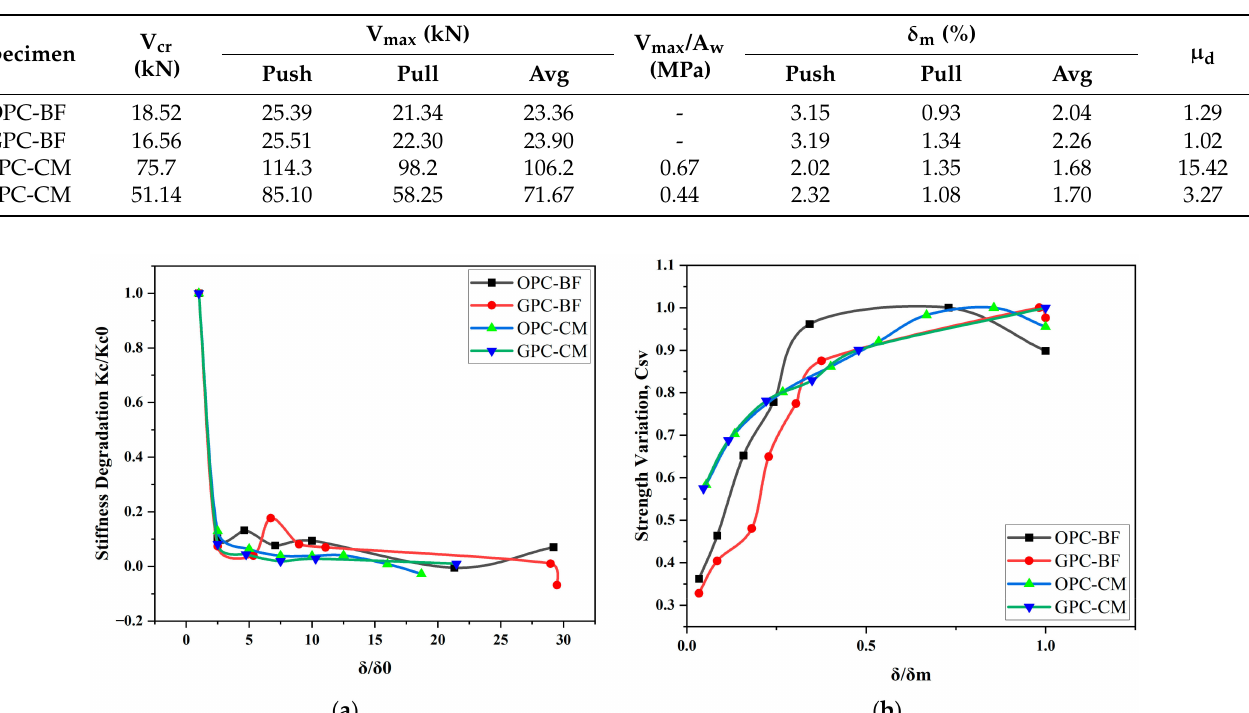
Table 4. Hysteretic response of test walls.